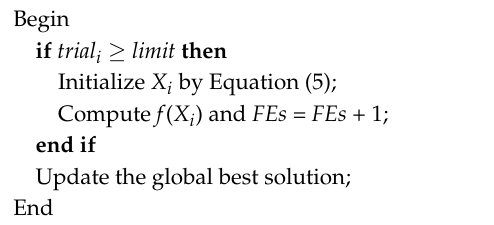
Algorithm 3: Framework of the Scout bee phase